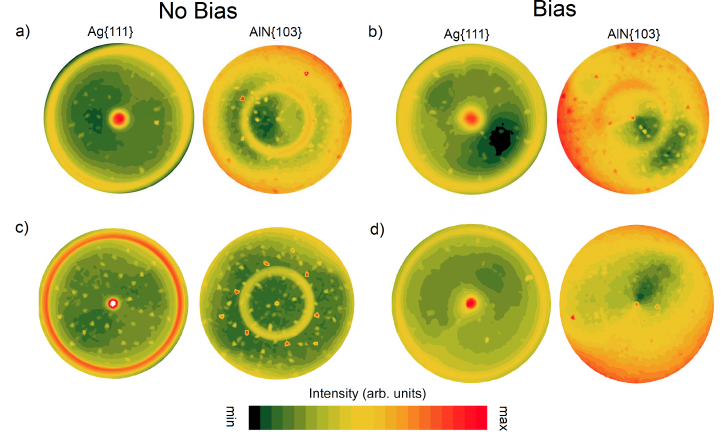
Figure 3. Pole figures of Ag { 111 } and AlN { 10¯13 } family of planes, as recorded from for the as deposited NMLs, produced ( a ) without substrate bias and ( b ) with substrate bias. The same pole figures as acquired after annealing of the NMLs in Ar at 700 ◦ C are shown in ( c , d